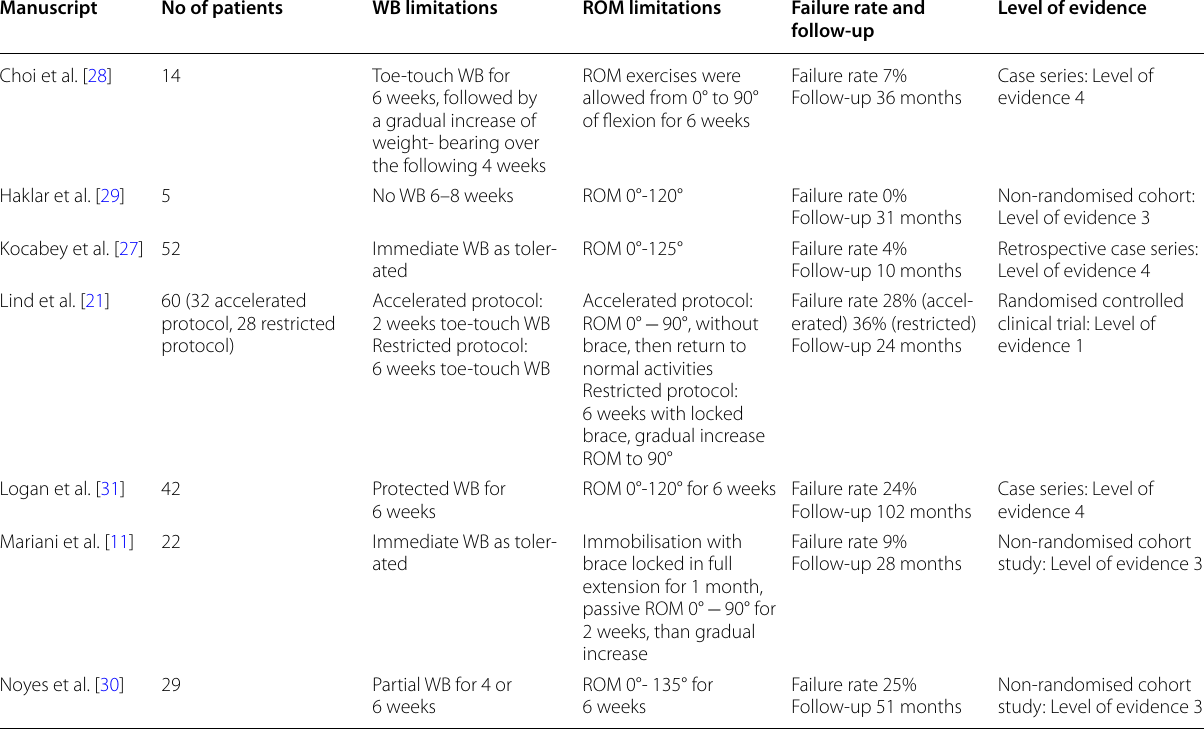
WB Weightbearing, ROM Range of motion